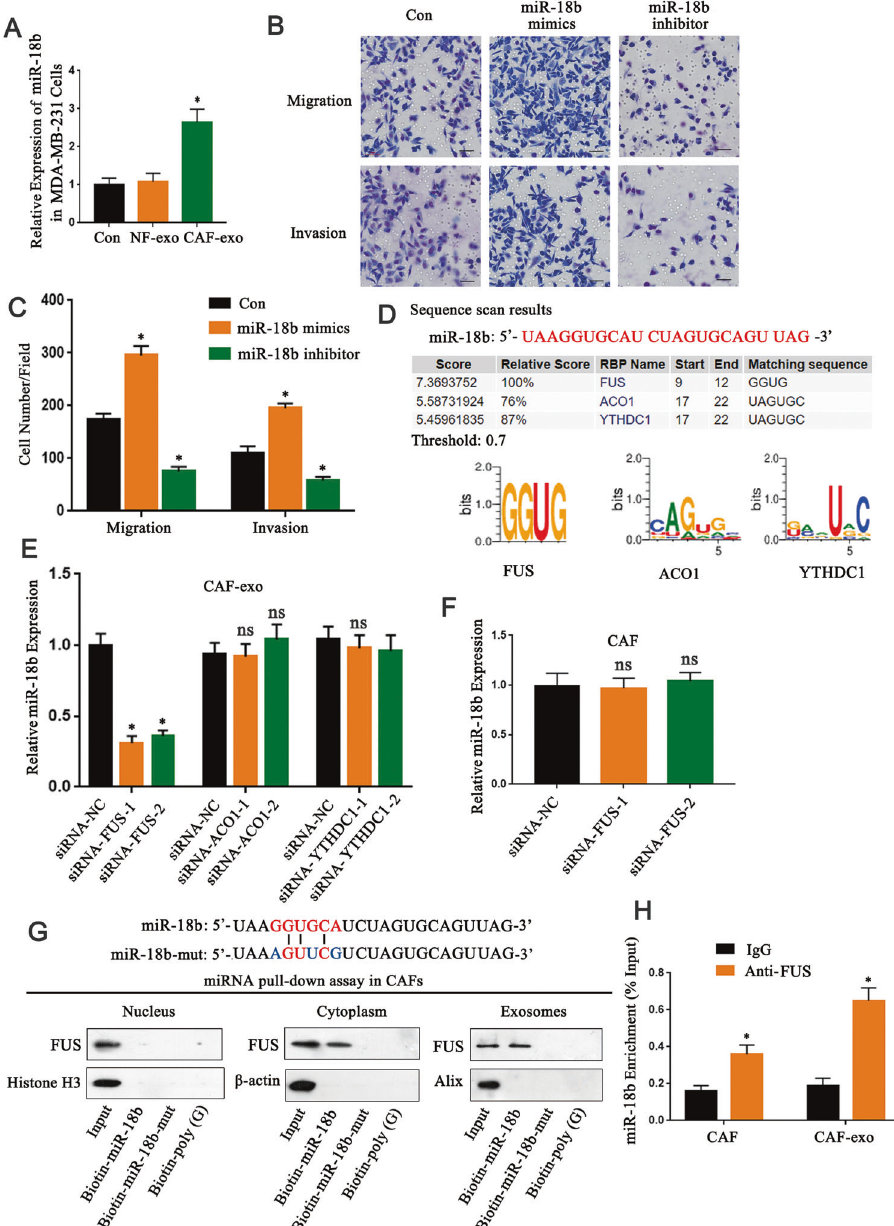
Fig. 3 The upregulated expression of miR-18b in exosomes enhanced migration and invasion of breast cancer cells. A qRT-PCR detected miR-18b expression in cancer cells co-cultured with NFs and CAFs-derived exosomes ( n = 3). B , C Transwell experiments demonstrated the effect of miR-18b on the ability of breast cancer cells in migration and invasion ( n = 3). Scale bar, 50 μ m. D RBPDB analysis was used to predict the speci fi c interaction between the miR-18b sequence and RBP motifs (threshold 0.7). E Using real-time PCR to measure the expression of miR-18b in CAFs-derived exosomes transfected with speci fi c siRNA targeting FUS, ACO1, or YTHDC1 ( n = 3). F Real-time PCR analysis detected the expression of miR-18b after silencing FUS in CAFs ( n = 3). G The miRNA pull-down experiment analyzed the interaction of miR-18b and miR-18b mutant with FUS in the cytoplasm, nucleus, and exosomal lysates of CAFs, biotinylated poly. H As a negative control ( n = 3). I Anti- FUS antibody (or IgG as a control) was used for RIP detection of CAFs cells or exosomal lysates ( n = 3). * indicates p < 0.05. The measurement data were expressed using mean ± SD, and the experiment was repeated three times. Comparisons between two groups are analyzed by t-test; one-way ANOVA was used for multiple data analysis groups.